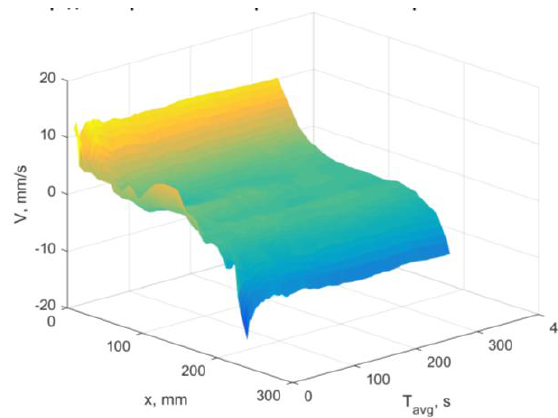
Fig. 3. Dependency of vertical velocity profile on averaging time.